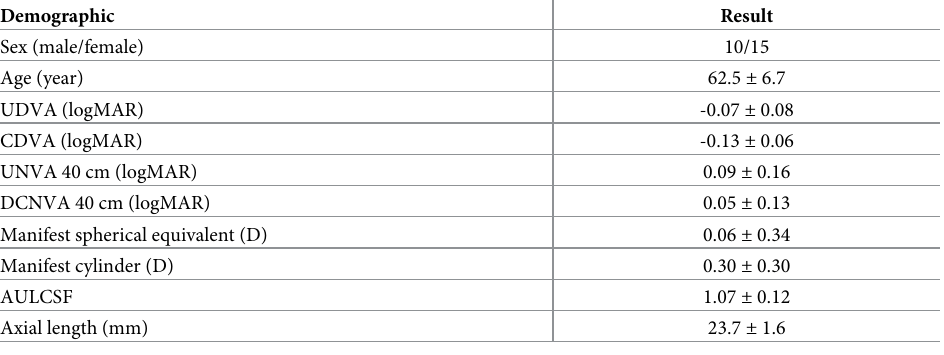
UDVA = uncorrected distance visual acuity; CDVA = corrected distance visual acuity; UNVA = uncorrected near visual acuity; DCNVA = distance- corrected near visual acuity; AULCSF = area under the log contrast sensitivity